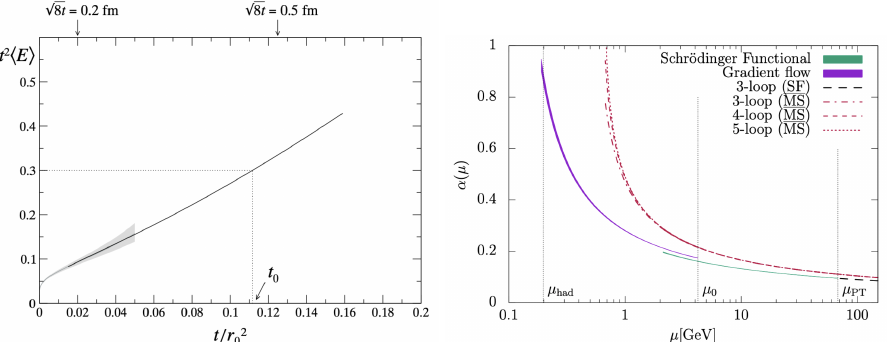
Figure 2. Left plot: Flow-time dependence of the energy t 2 gray band is the prediction for perturbative QCD (see text) and t 0 denotes the flow time value where (cid:69)(cid:12) (cid:12) (cid:68) = 0.3. Right plot: running coupling as a function of the renormalization scale for 3 dif- (cid:12) (cid:12) t 0 G µν G µν t = t 0 ferent schemes: the GF scheme described in the main text, the MS scheme, and what is denoted as the Schrödinger functional